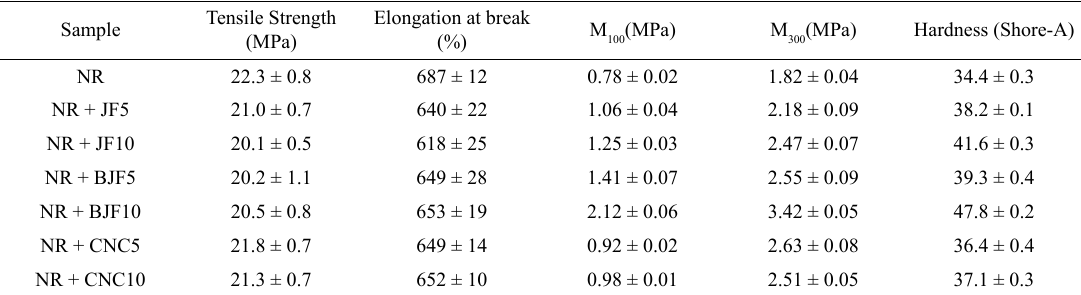
Table 4. Mechanical properties of NR and NR composites.